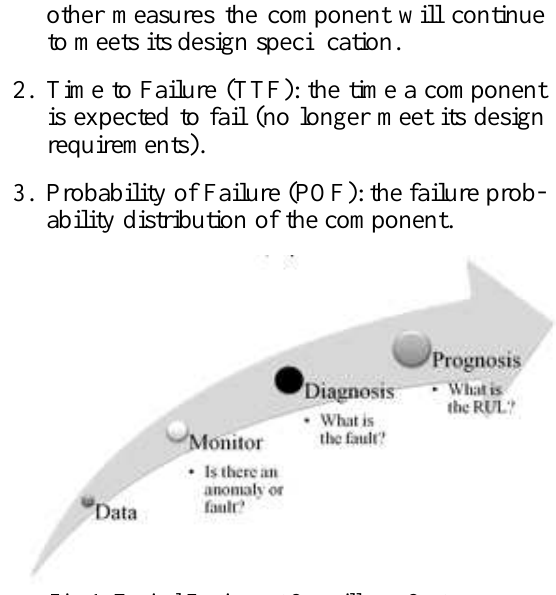
Fig. 1. Typical Equipment Surveillance